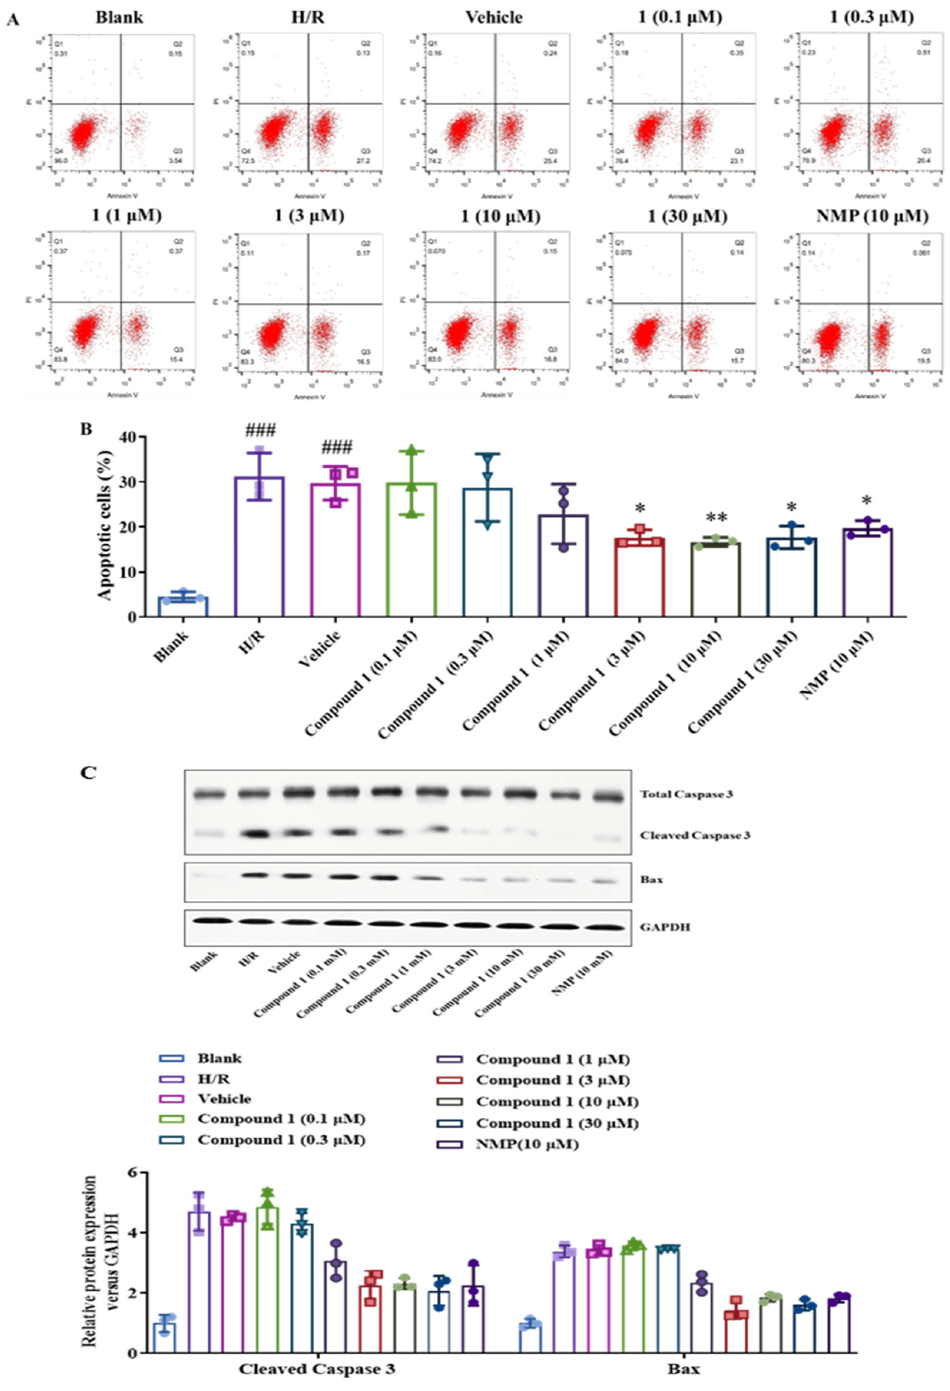
Figure 7. ( A ): Distribution of apoptosis measured by flow cytometry. ( B ): Bar graph of Apoptosis. ( C ): Western blot image of Total Caspase 3, Cleaved Caspase 3, Bax, GAPDH protein. Bax and Cleaved Caspase 3 protein expression. Protein content was normalized to GAPDH. Data represent mean ± SD (* p < 0.05, ** p < 0.01, vs. H/R Group; ### p < 0.001, vs. Blank Group).